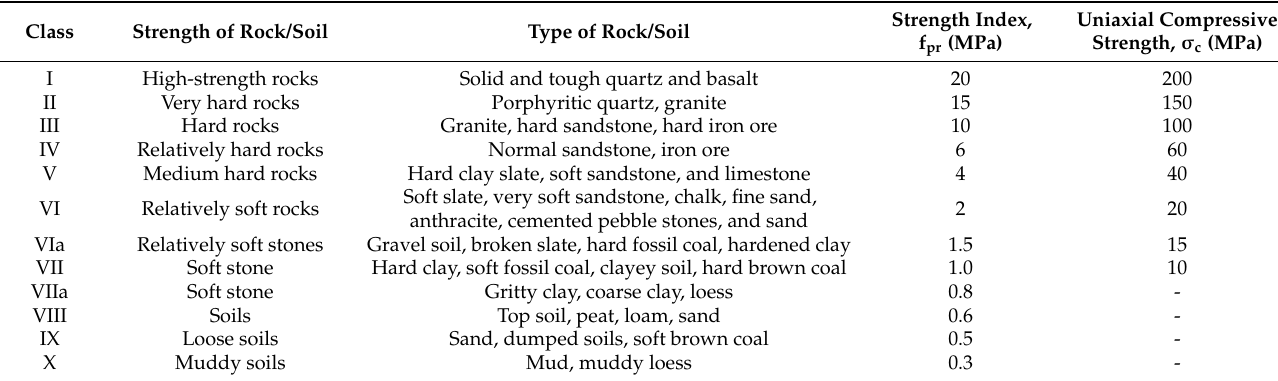
Table 1. Protodjakonow classification of the rocks and soils [14].